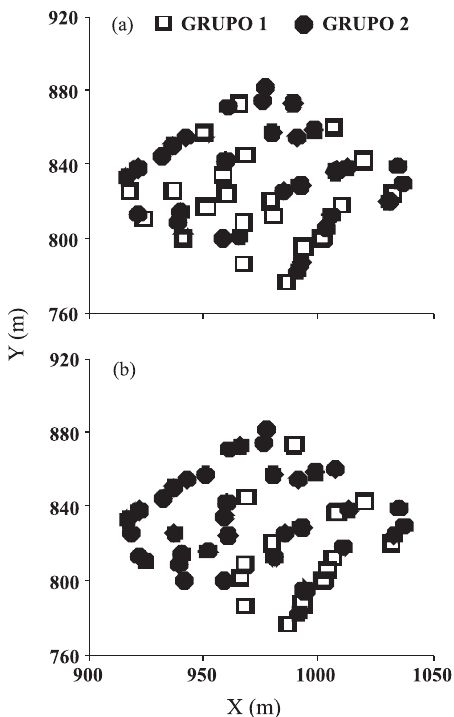
figure 4. distribution of sampling points according to the cluster analysis for the real variables (a) and seven main components